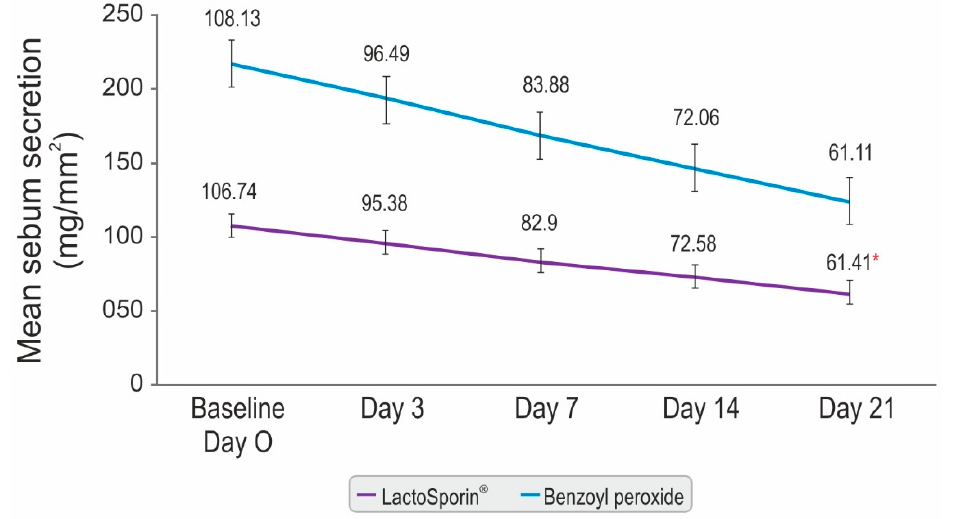
Figure 4. Analysis of sebum secretion (µg/cm 2 ) by Sebumeter was done at day 0, day 3, day 7, day 14 and day 21. Values are expressed as mean ± SE, * p < 0.05 in comparison to benzoyl